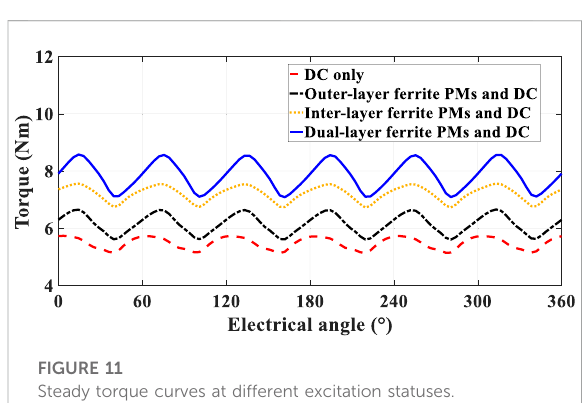
FIGURE 11 Steady torque curves at different excitation statuses.